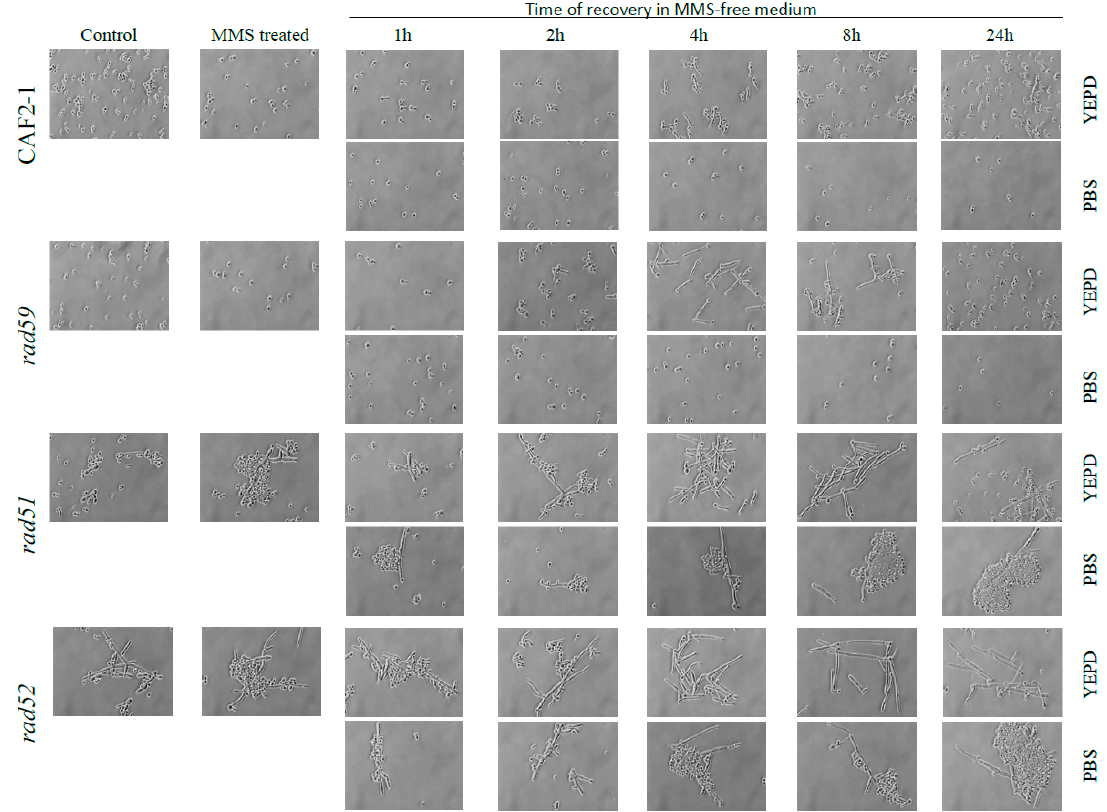
Figure 3. Induction and repair of HDBs by C. albicans cycling and resting wild type cells. C. albicans wild type (CAF2-1) was subjected to an acute MMS treatment (0.05% MMS for 30 min). Then cells were treated with 5% sodium thiosulphate, by mixing 1:1 ( v / v ) ratio with 10% Na 2 S 2 O 3 , washed with PBS, and transferred to MMS-free YPD (cycling cells) or PBS (resting cells) at 30 °C. Samples were taken at the indicated times to determine PFGE profiles ( A ), to quantify Chr2 and Chr5 ( B ) and to calculate CFU and OD 600 ( C ). For PFGE profiles, DNA plugs were incubated with proteinase K at 55 °C. Of note, in panels B and C , initial time (0) corresponds to samples before MMS treatment. Arrows in panel B shows the MMS-treated sample.